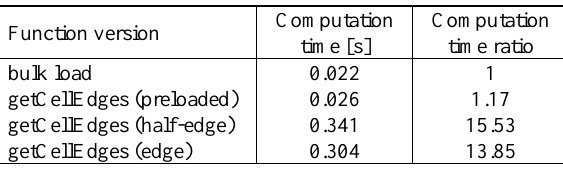
Table 3. Loading time of the TIN model.